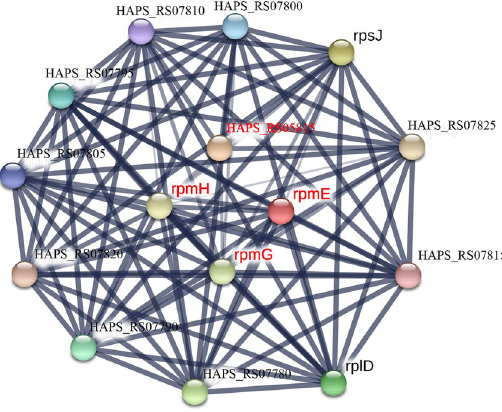
Figure 7. STRING analysis of the relationship between 15 DE genes in ribosome. The downregulated genes were marked with red, and the others were upregulated